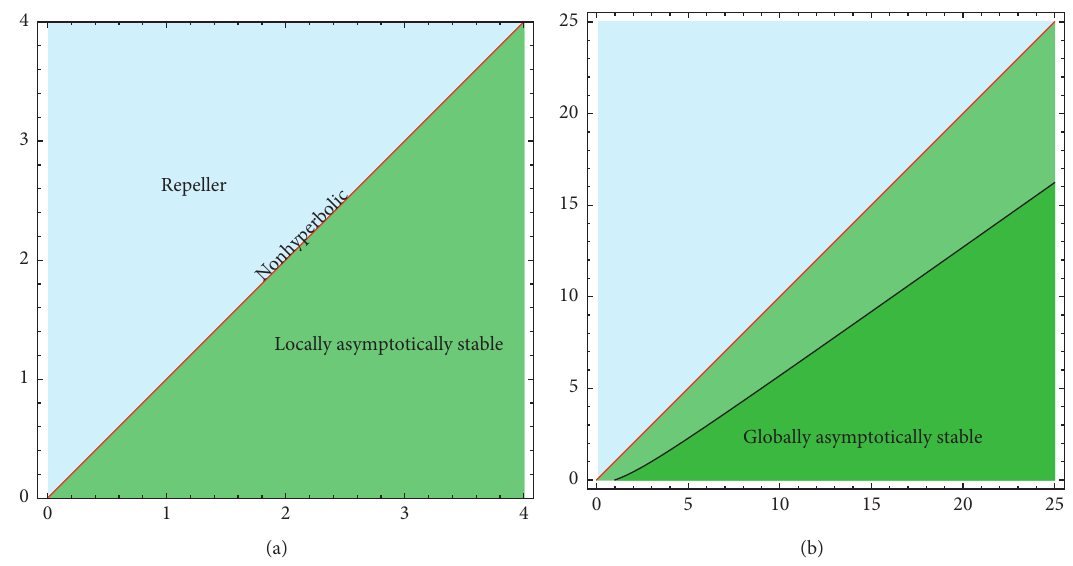
Figure 1: Local (a) and global (b) asymptotic stability in ( p, q )